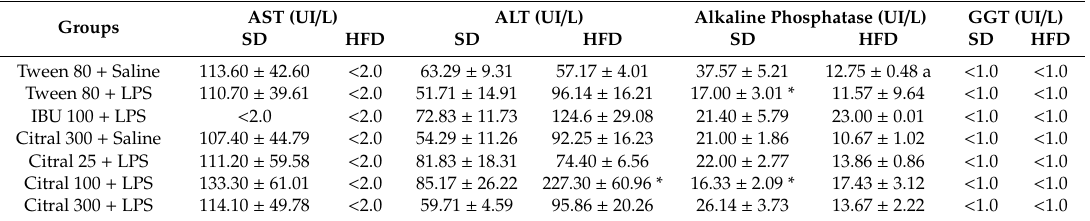
Table 7. E ff ect of citral on biochemical parameters of hepatic function in eutrophic (SD) and obese mice (HFD).